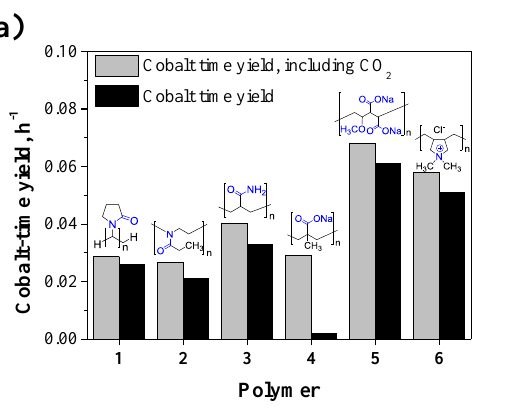
Figure 4. ( a ) Cobalt time yield and ( b ) product selectivity in the AFTS catalyzed by unsupported CoNPs, as a function of the polymeric stabilizer. Conditions: 0.949 mmol Co, 30 bar H 2 /CO/Ar (2:1:0.15), 66 mL water, 1000 rpm, 180 °C, 12h.